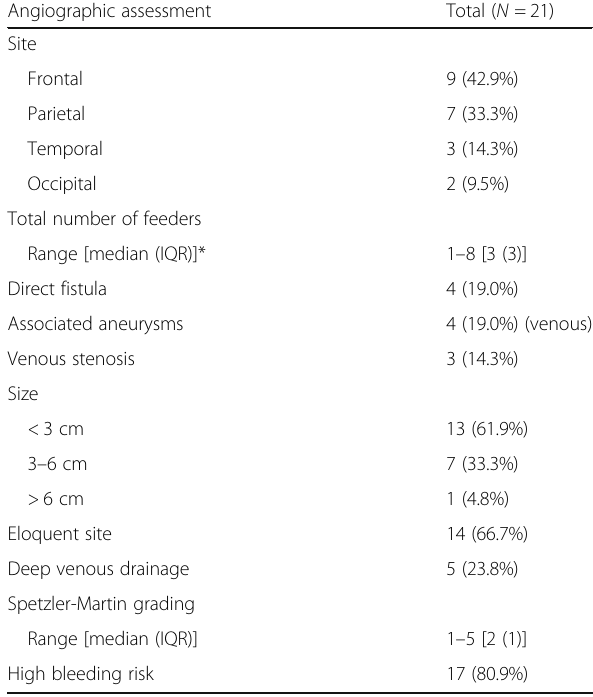
Table 2 Angiographic